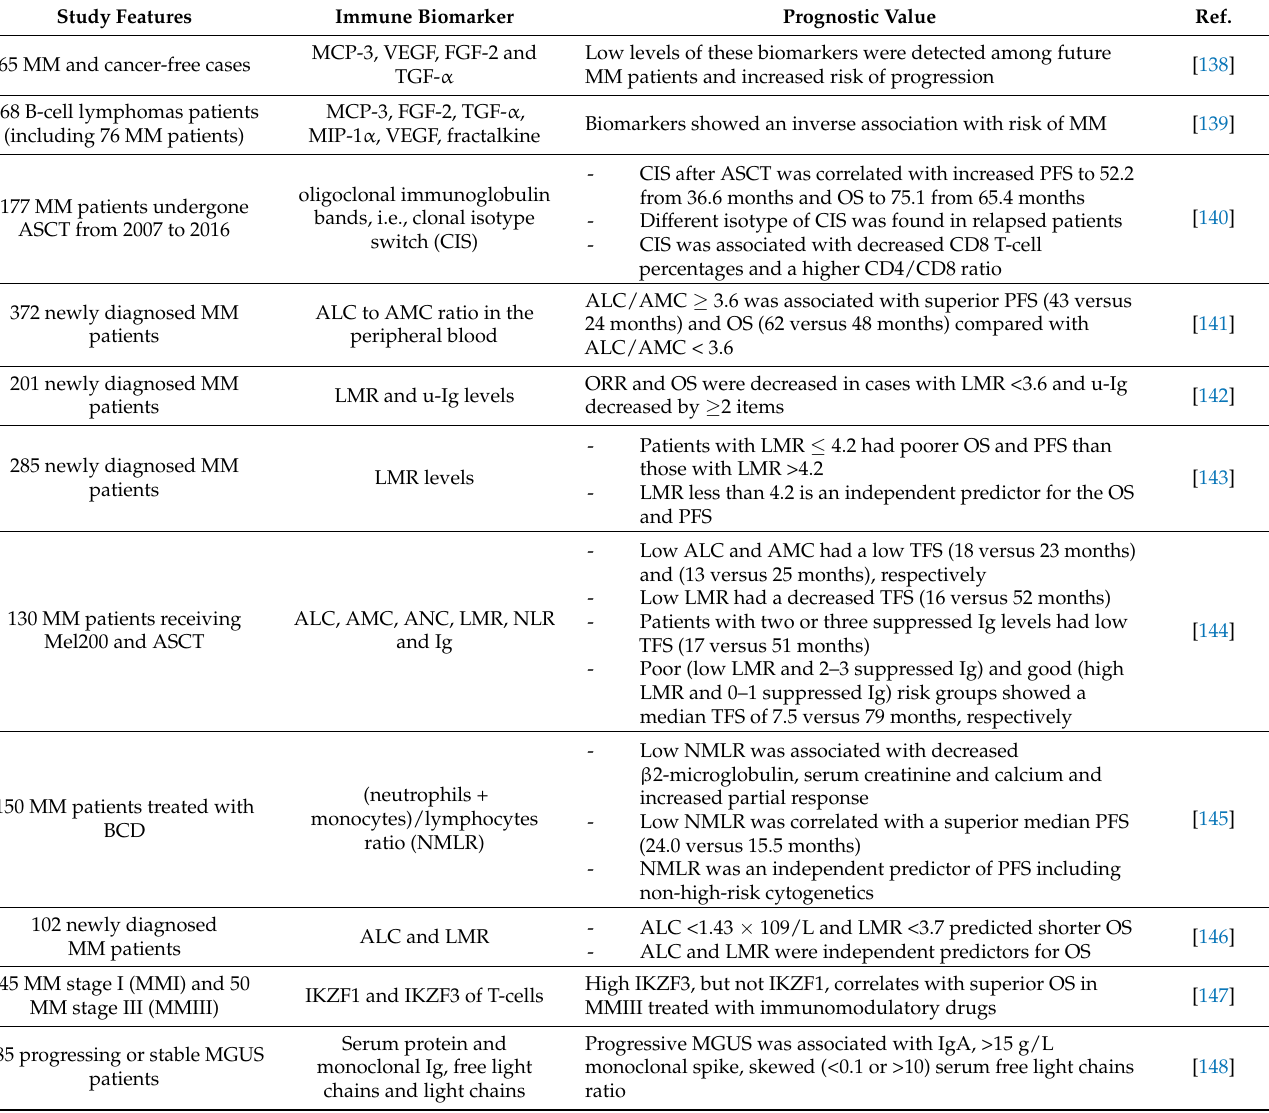
Table 3. Immune biomarkers and their prognostic role in